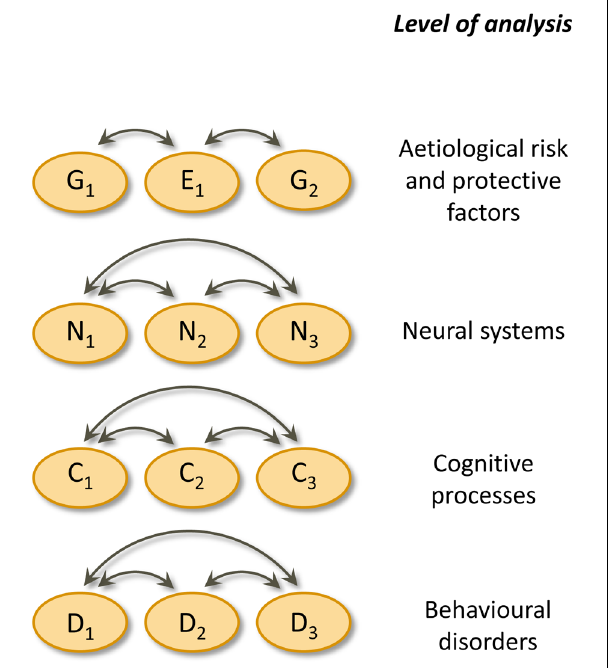
FIGURE 1 | Pennington’s multiple deficit model. Double headed arrows indicate interactions. Causal connections between levels of analysis are omitted. G = genetic risk or protective factor, E = environmental risk or protective factor, N = neural system, C = cognitive process, D = complex behavioural